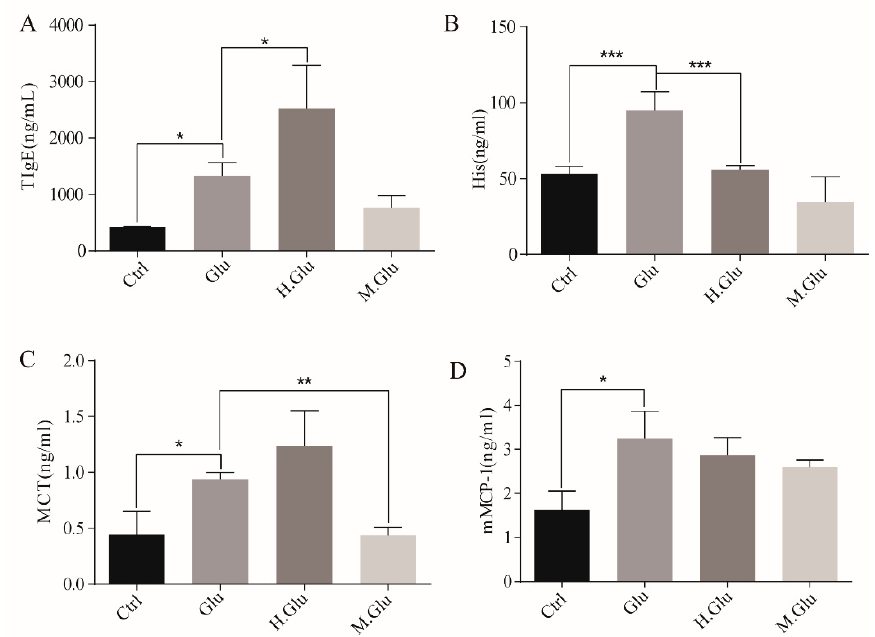
Figure 3. MGO-glutenin induced a lower immune response than glutenin. Ctrl represents the control group and Glu, H.Glu, and M.Glu represent native glutenin, heated glutenin, and MGO-glutenin, respectively. The bars indicate the serum levels of total IgE ( A ), His ( B ), MCT ( C ), and mMCP-1 ( D ). Data are presented as mean ± SEM. Significant di ff erences of Glu versus H.Glu and M.Glu groups are indicated as * p < 0.05, ** p < 0.01, *** p <